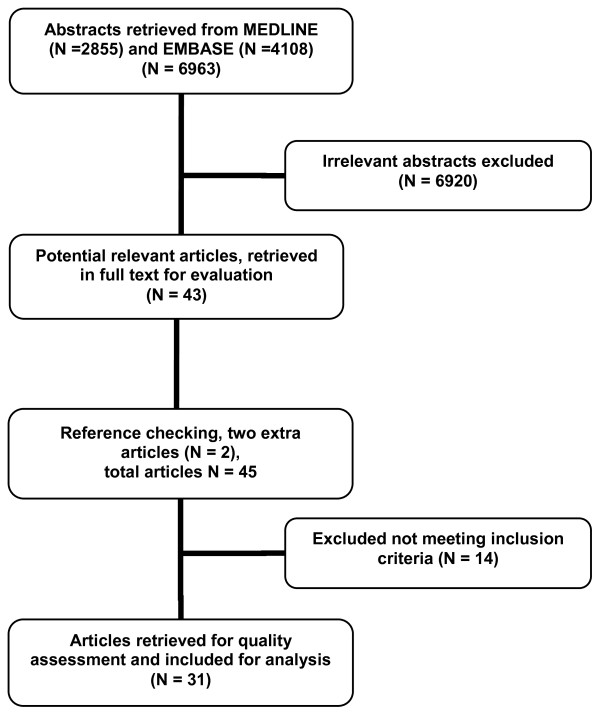
Selection and number of publications.